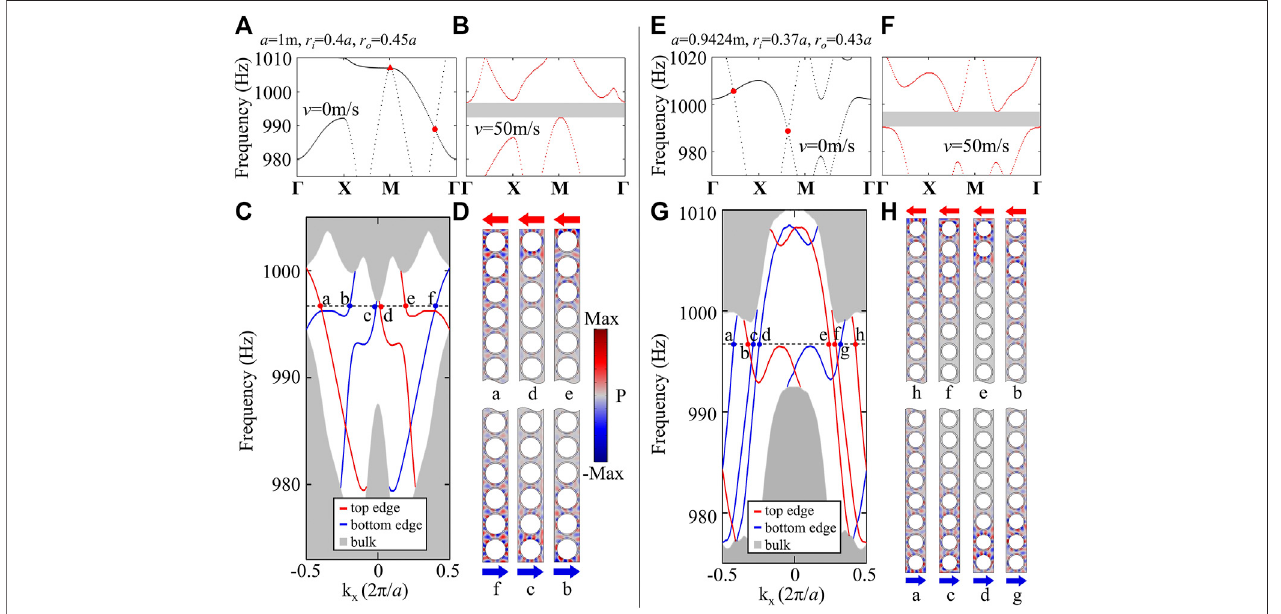
FIGURE 3 | Band structures and one-way edge modes in SC3 with C (cid:2) 3 and SC4 with C (cid:2) 4. (A – D) Respectively the bulk band structures for SC3 without air fl ow,withair fl ow,theprojectedbandstructureoftheribbonsupercellandtheassociatedmodepro fi lesoftheone-wayedgemodes.ThegeometricparametersforSC3 are listed in (A) . (E – H) The same as that in (A – D) , only for SC4 with C (cid:2) 4. The geometric parameters of SC4 are listed in (E) . All marked edge modes are at 996.7